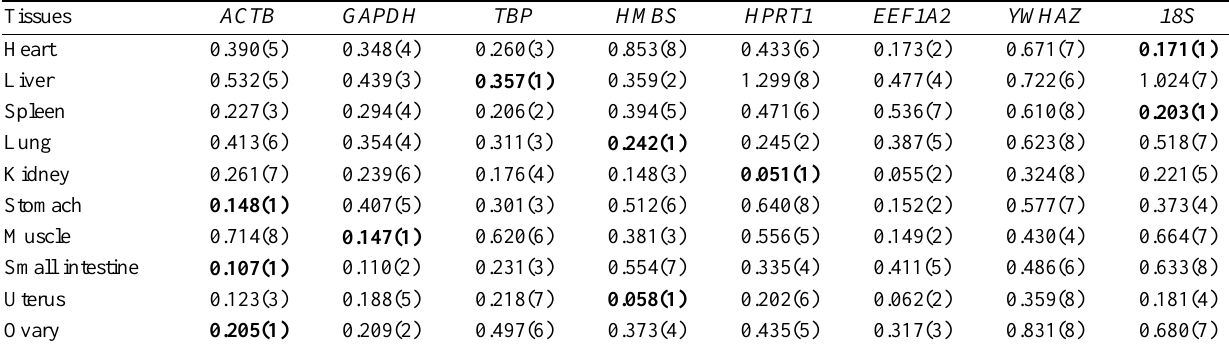
Table 4. Stability values (M-values) for each reference gene calculated by using geNorm algorithm